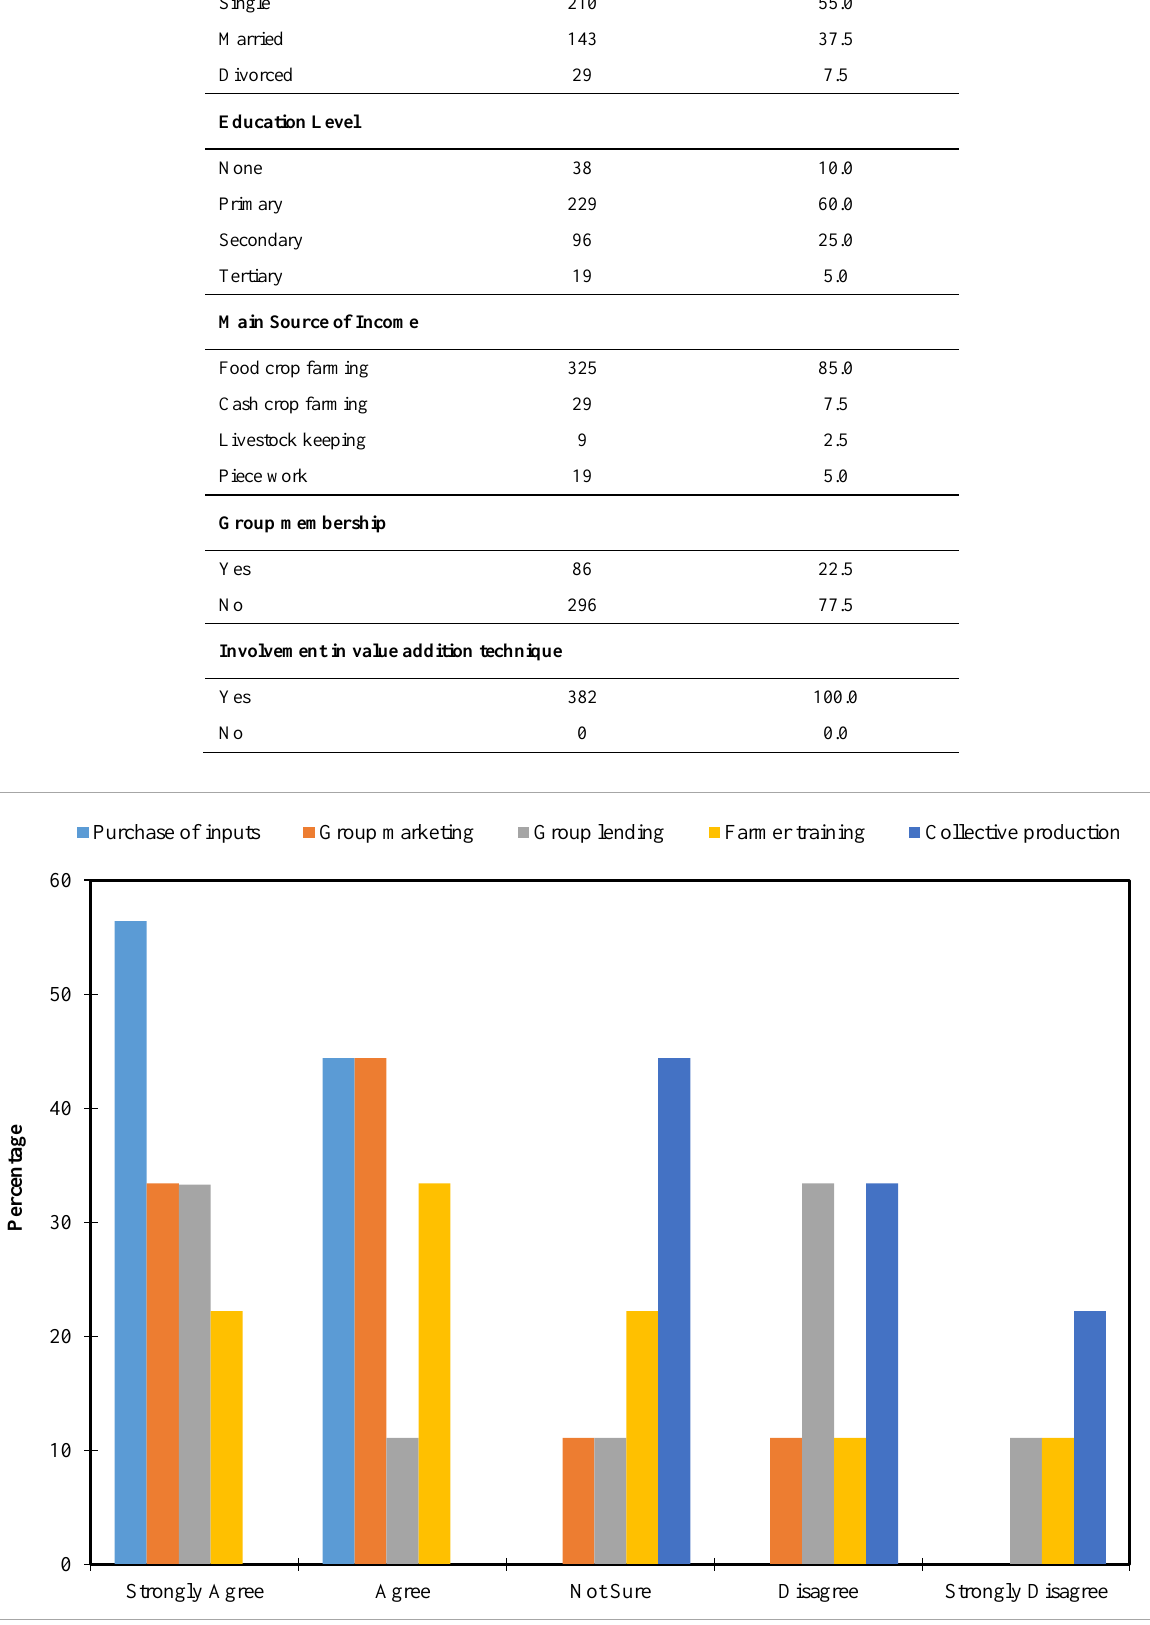
Figure 2. Reasons for joining Irish potato production group X 2 =17.361; df=4